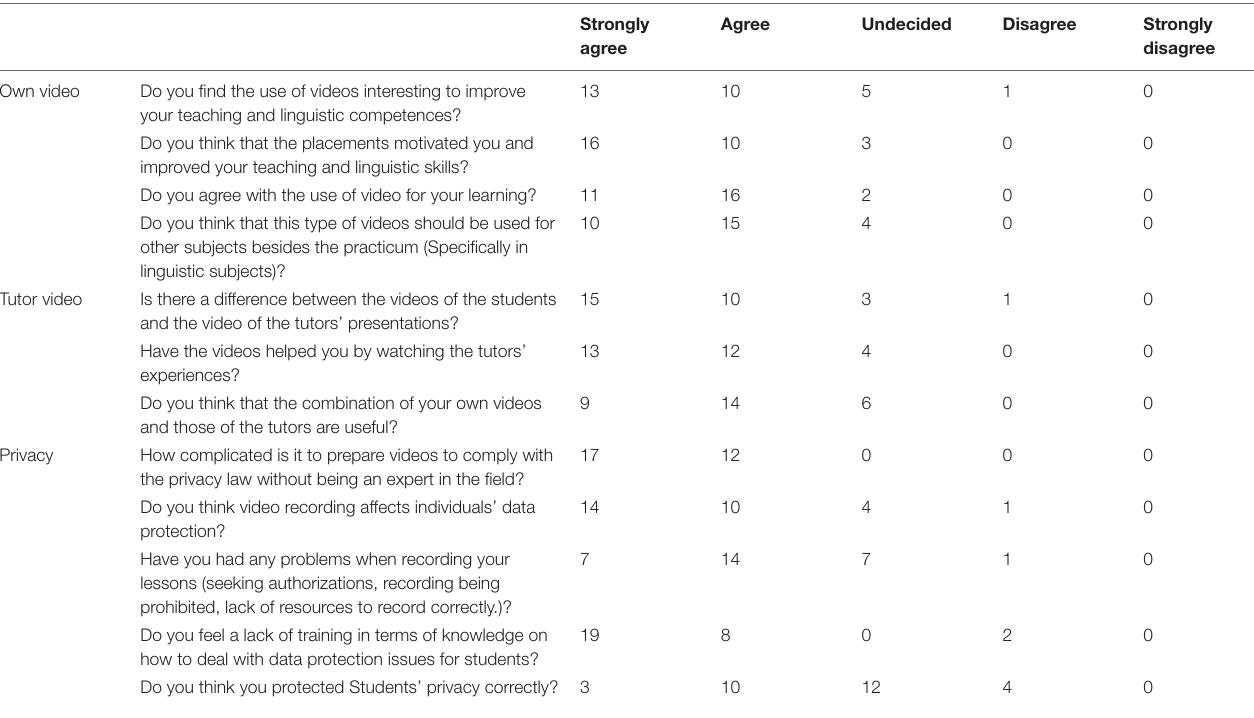
TABLE 2 | Questionnaire and accumulated data by